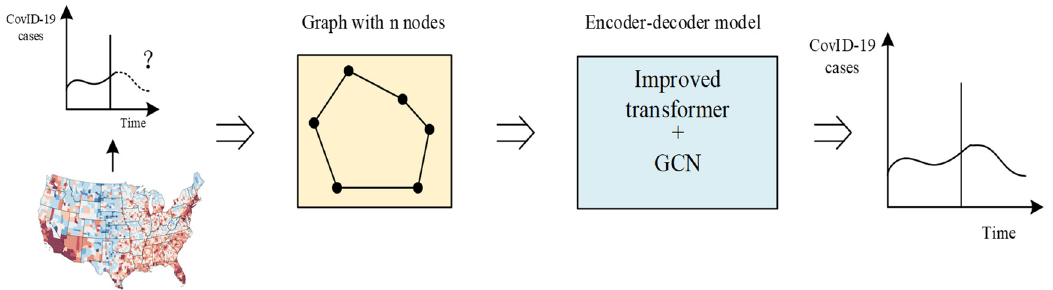
Figure 1. Framework of model.